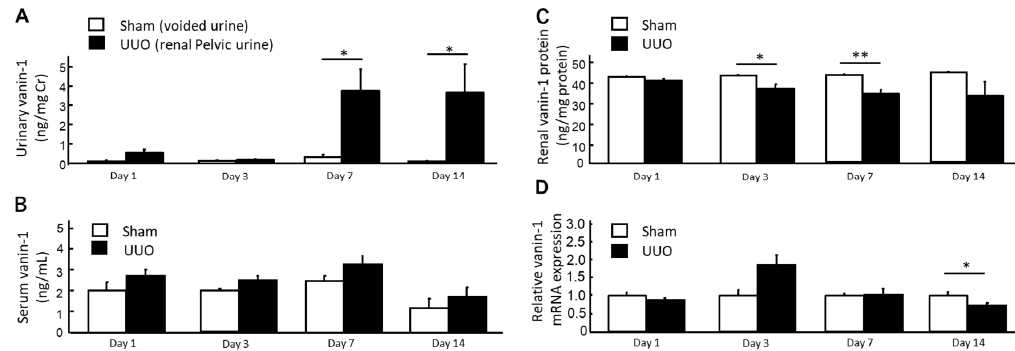
Figure 3. Accumulation of vanin-1 in the renal pelvic urine of rats with UUO. ( A , B ) Released vanin-1 was detected in the renal pelvic urine, but not in the serum, on days 7 and 14 after UUO ( n = 5 for each time point in each group). Data represent the mean + SE. * p < 0.05 vs. the sham-operated rats (by one-way ANOVA followed by Tukey’s post hoc analysis). ( C , D ) Vanin-1 protein and mRNA expressions in the renal cortices of the obstructed kidney (UUO, n = 5 per time point) were decreased compared with those of sham-operated kidney (Sham, n = 5 per time point). Data represent the mean + SE. * p < 0.05 and ** p < 0.01 vs. the sham-operated rats (by one-way ANOVA followed by Tukey’s post hoc analysis).